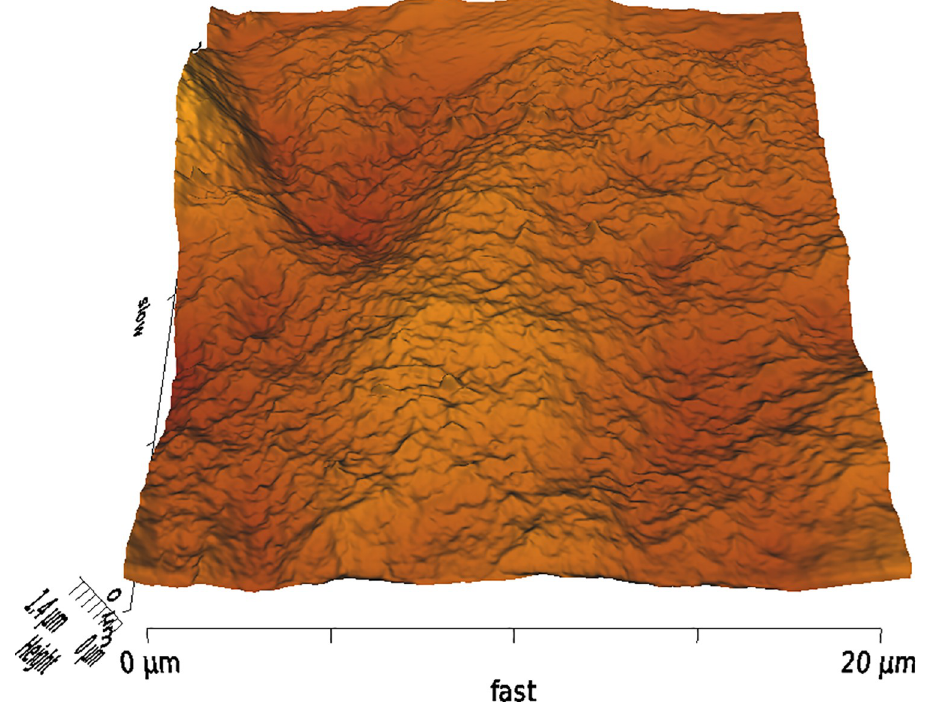
Fig 5. Example image of corneal surface treated with FS2 with 3D AFM